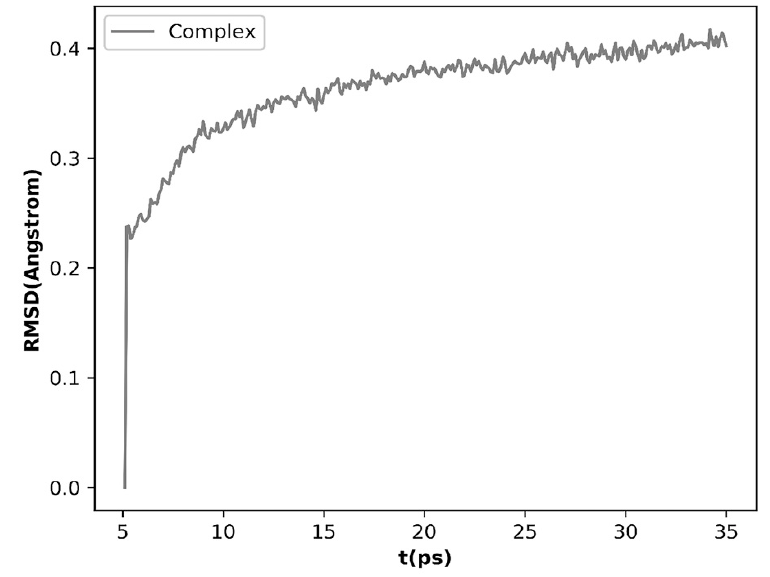
Figure 5. ( A ) Optimal binding modes of compound 17 in squalene epoxidase (PDB ID 2AIB); ( B ) 2D interaction plot of 2AIB and compound 17 . The structural framework of compound 17 was marked with green color. Protein skeleton of 2AIB was marked with red color. The atoms involved in the path are identified as colored stick. (Oxygen (red), nitrogen (blue), hydrogen (white)).